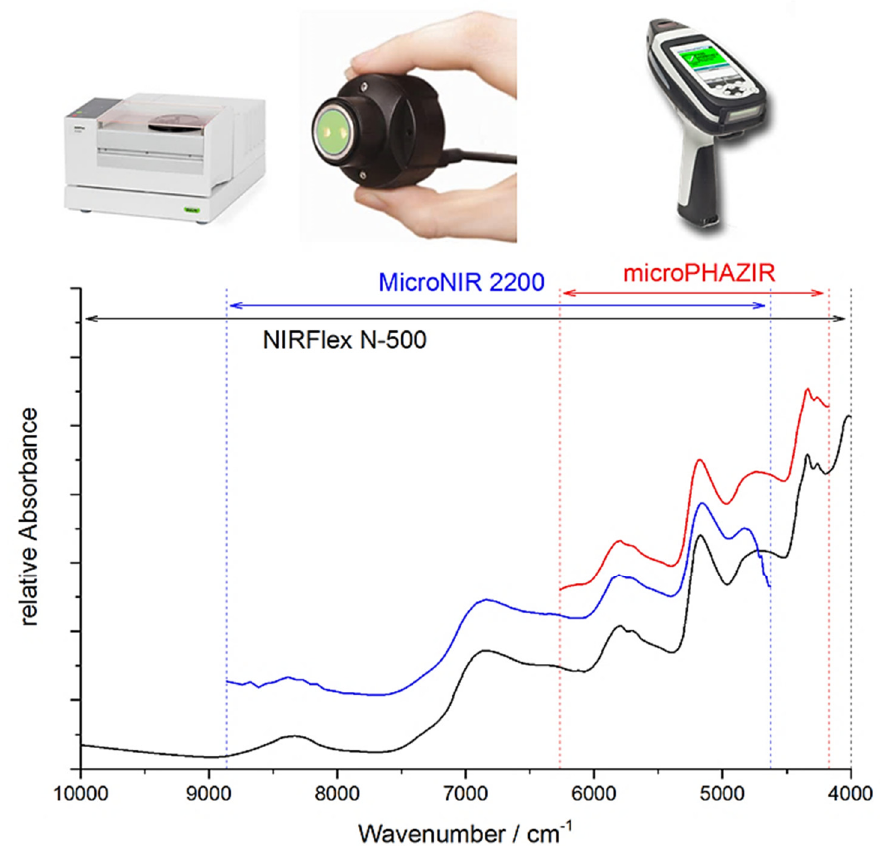
Figure 7. In contrast to benchtop FT-NIR instruments that measure the full NIR wavenumber region, the access of miniaturized NIR spectrometers to chemical information is selective, resulting from only narrow, and at best partially overlapping, fragments of the NIR spectra measured by these sensors. Adopted with the permission of the Royal Society of Chemistry (2017) from [27].